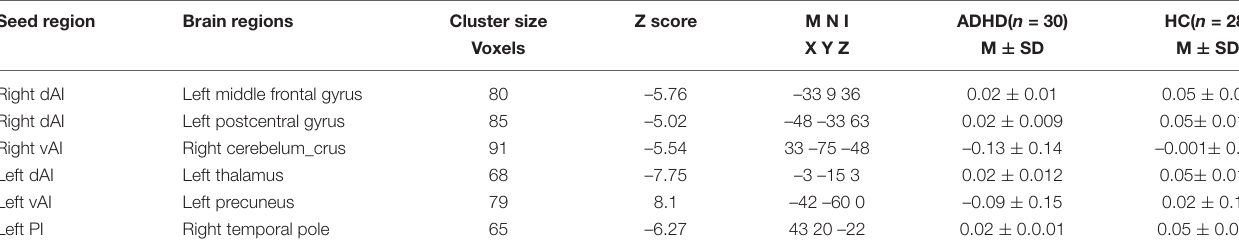
TABLE 1 | Brain clusters showing significant effects in the dFC of insular subregions. Seed